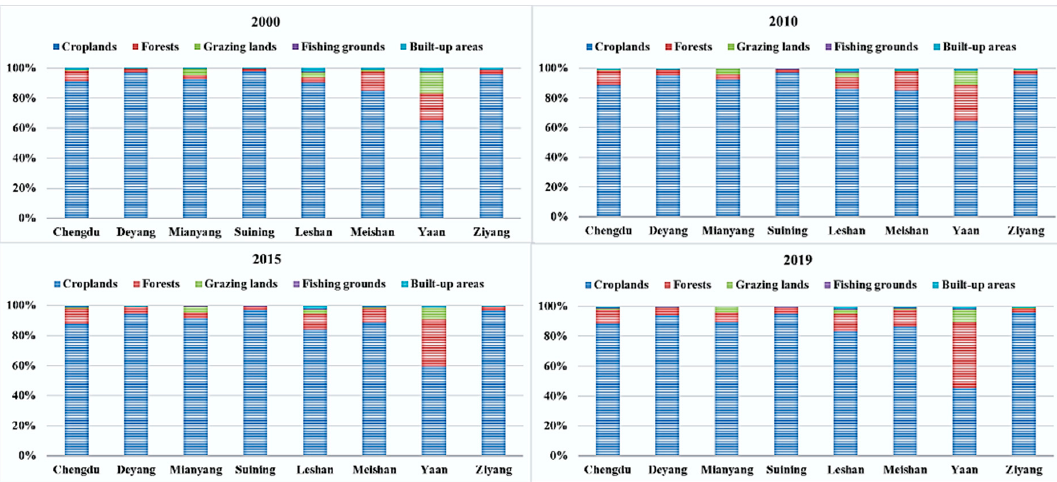
Figure 4. the EF depth of land types composition from 2000 to